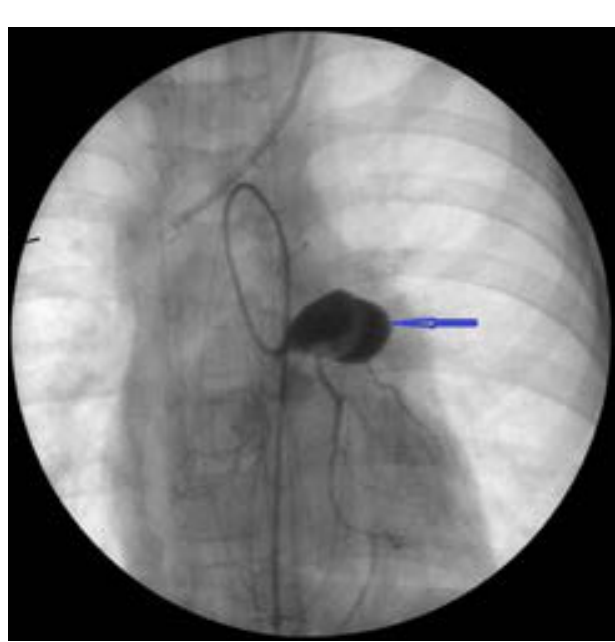
Fig. 2 – Giant aneurysm of the left coronary artery trunk in a 7-year- old child with Kawasaki